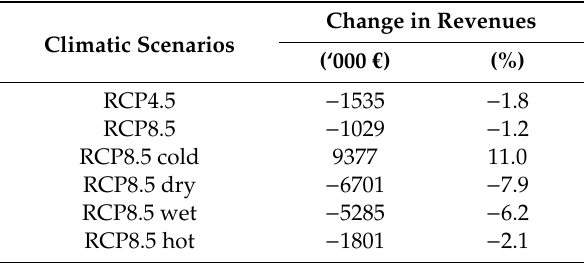
Table 13. Change in the expected total revenues from the examined crops and climatic scenarios compared to the average revenues of the period